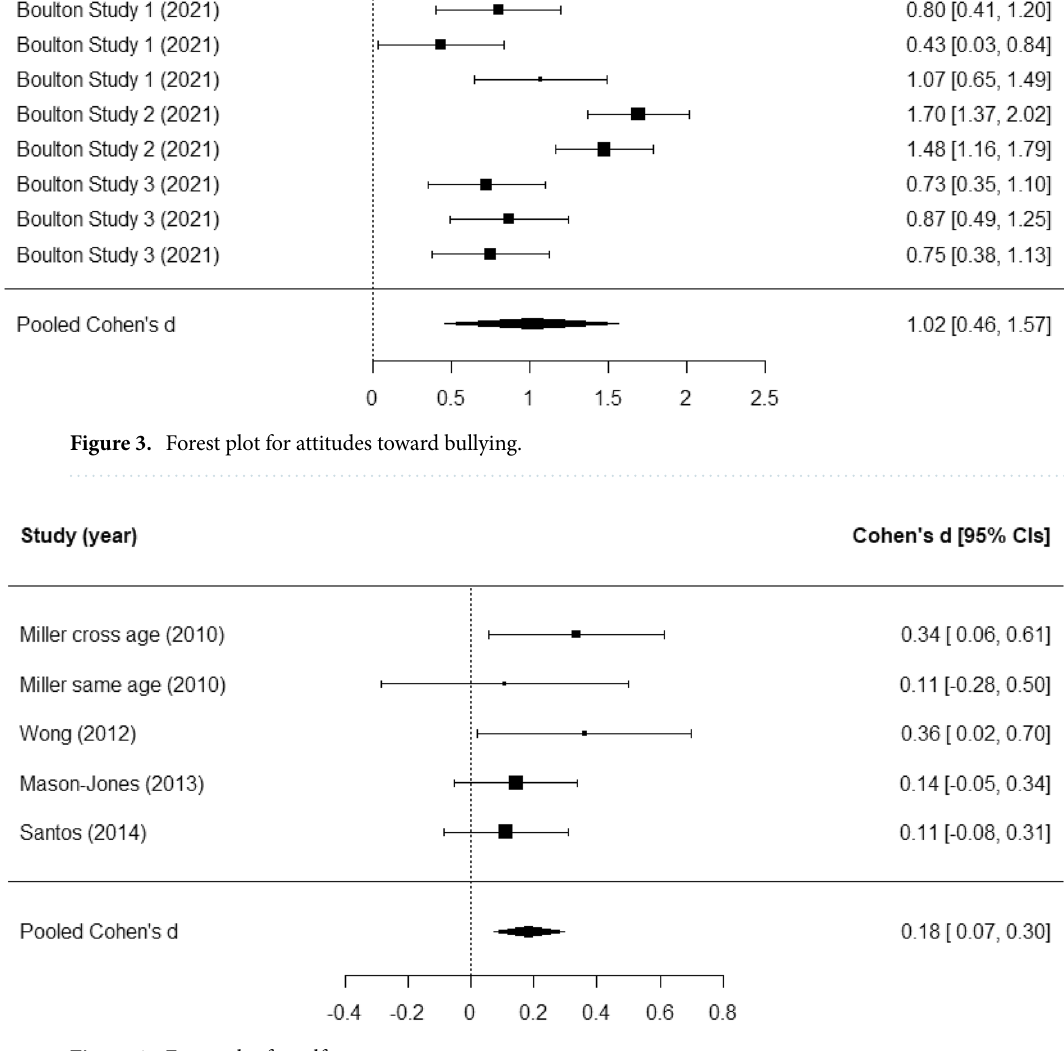
Figure 4. Forest plot for